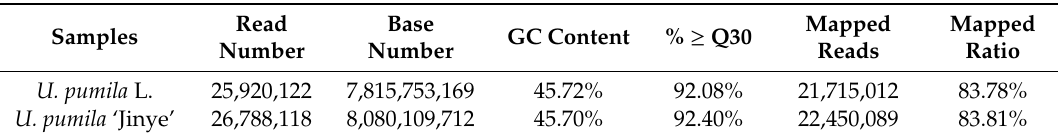
Table 2. Sequencing data evaluation statistics.